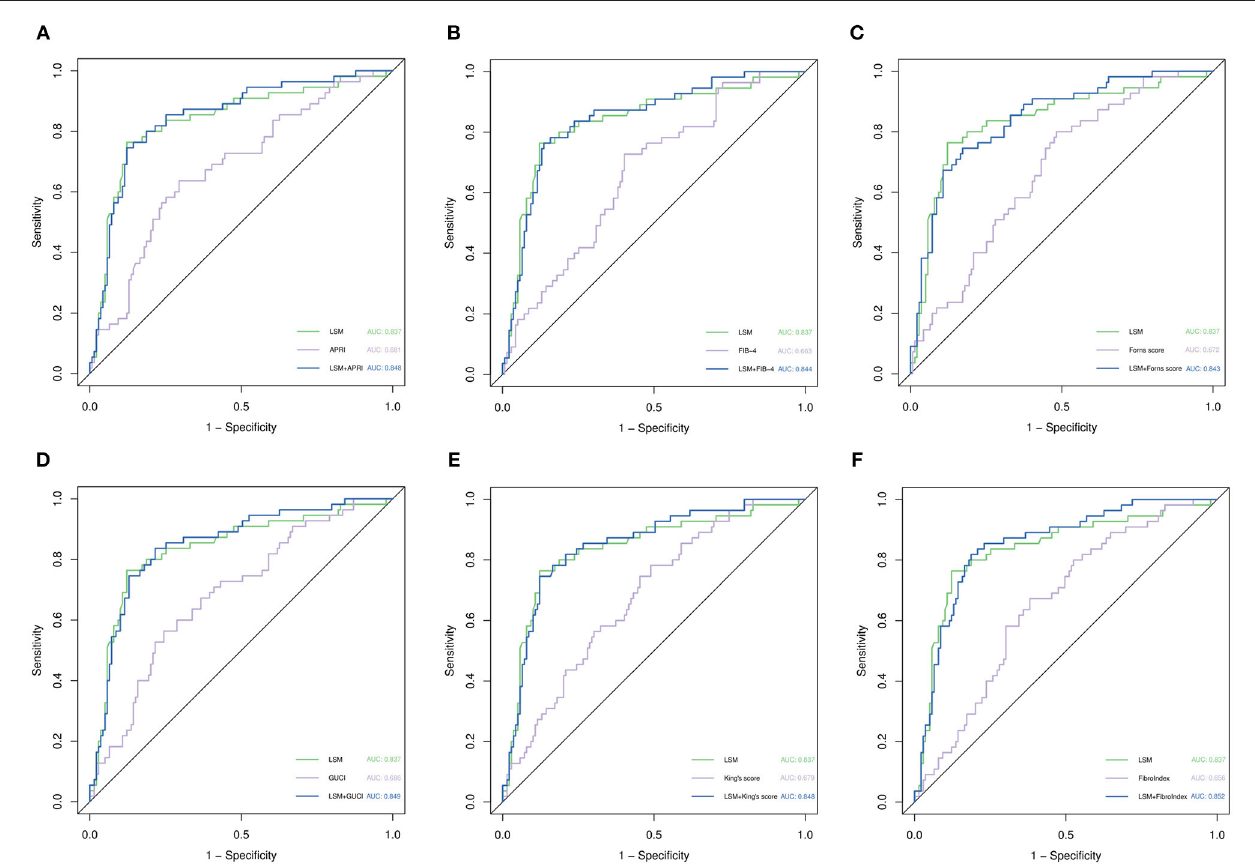
FIGURE 4 | ROC curve analysis for predicting rebleeding by various parameters. (A) Comparison of LSM, APRI, and their combined ROC curves. (B) Comparison of LSM, FIB-4, and their combined ROC curves. (C) Comparison of LSM, Forns score, and their combined ROC curves. (D) Comparison of LSM, GUCI, and their combined ROC curves. (E) Comparison of LSM, King’s score, and their combined ROC curves. (F) Comparison of LSM, Fibrosis index, and their combined ROC curves. p -values are from the DeLong test